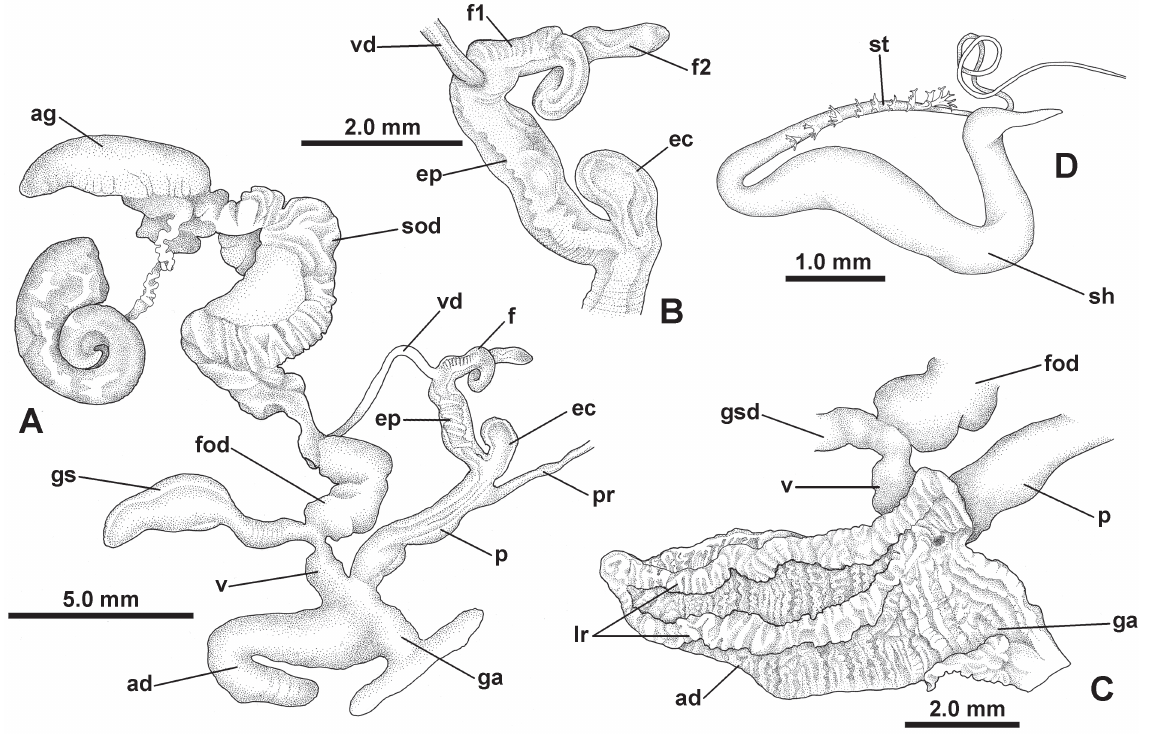
Fig. 12. Sheldonia monsmaripi sp. nov., genitalia, paratype (NMSA W3653/T3169). A . Entire genital system. B . Flagellum and distal epiphallus. C . Internal structure of genital atrium and atrial diverticulum. D .